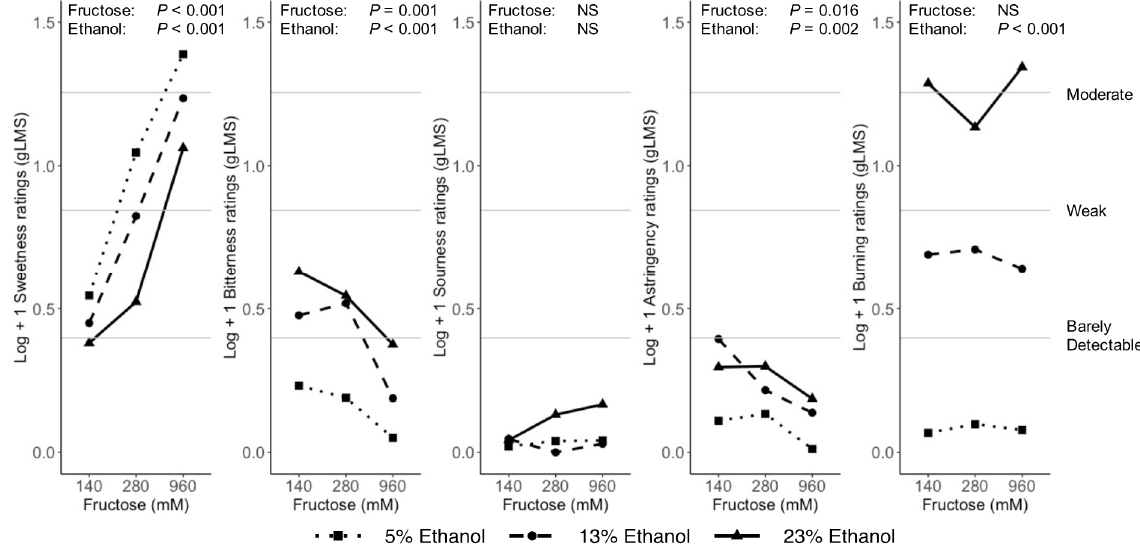
Figure 4. Mean ratings of sweetness, bitterness, sourness, astringency and burning/tingling in the binary solutions of ethanol (5%, 13%, 23% v/v ) and fructose (140 mM, 280 mM, 960 mM). Significant differences are indicated from the p -values above each graph (NS = not significant). A full summary of the model including the effect of thermal taste status and 2-way interactions is included in Table S2.